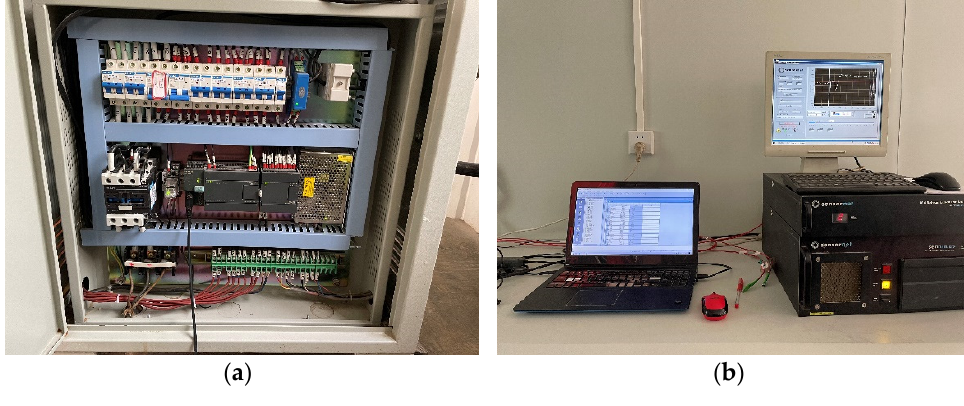
Figure 3. ( a ) Thermal responder; ( b )